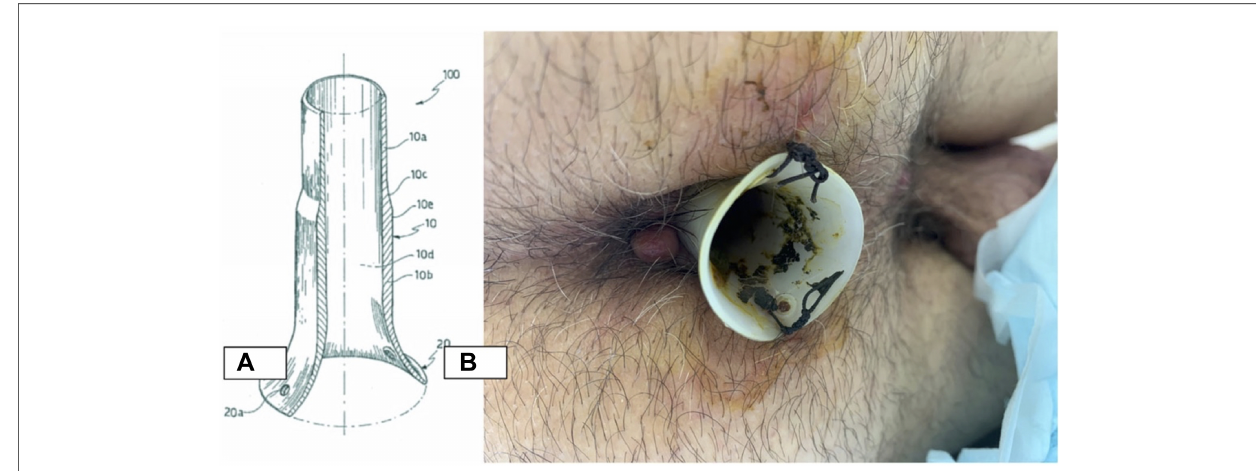
FIGURE 1 No coil structure and postoperative placement. ( A ) Length of 60 – 80 mm, thickness of 2 mm, and diameter of 20 mm. ( B ) Stabilized 6 – 8 cm far from the anus through two